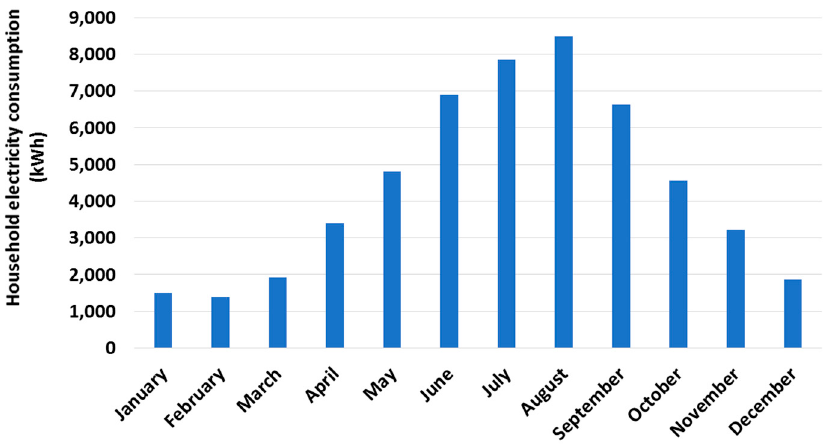
Figure A2. Sectoral annual percentage change in CO 2 emissions (2011–2018) Source: [56].